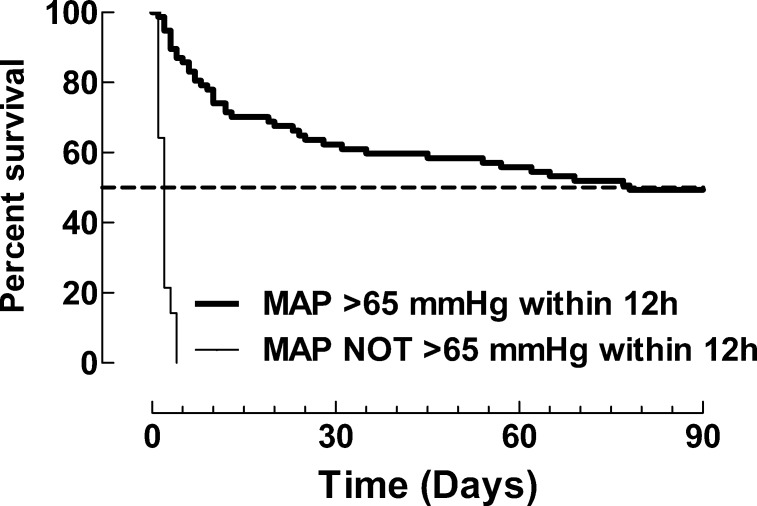
Mortality (%) for patients achieving versus not achieving MAP >65 mmHg within 12 hours.Kaplan-Meier curve with mortality (%) as outcome for patients achieving versus not achieving MAP >65 mmHg within 12 hours. p<0.0001 (Gehan-Breslow-Wilcoxon Test).